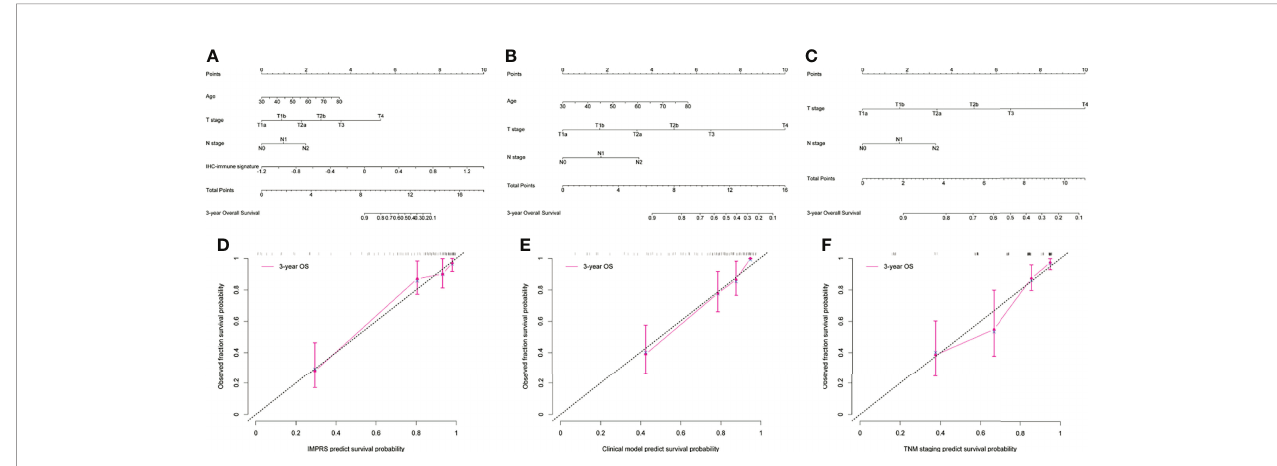
FIGURE 4 | Visualization and calibration of the prognostic model. (A – C) The visualization of the prognostic model as a nomogram for patients with resected NSCLC ( A for IMPRS, B for clinicopathologic-based model, C for TNM staging system). (D – F) The calibration curves for predicting overall survival (OS) at each time point ( D for IMPRS, E for clinicopathologic-based model, F for TNM staging